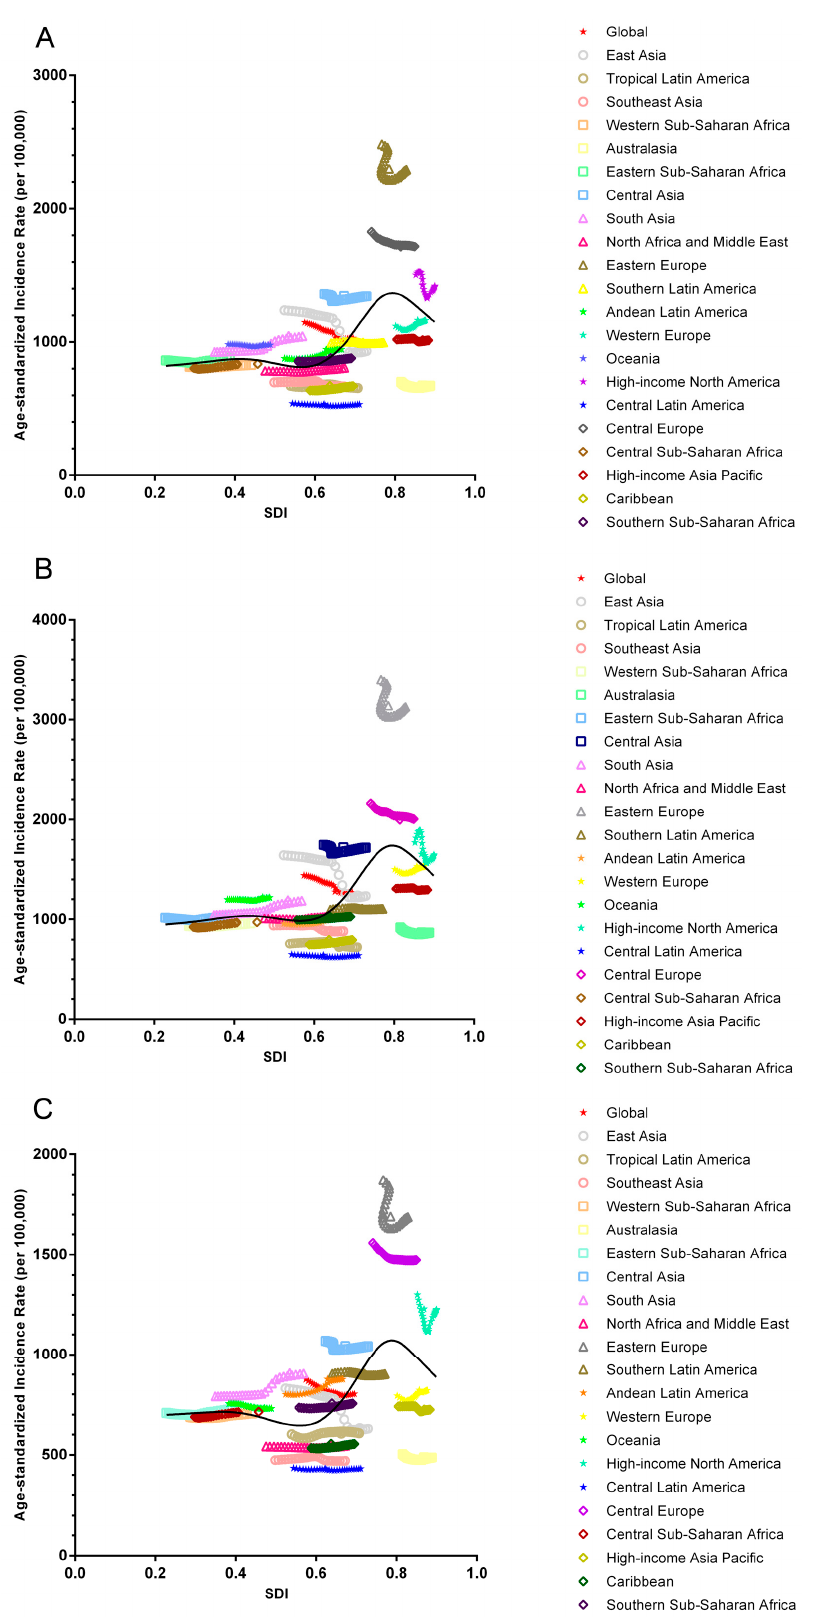
Figure 3. Annual percentage change of disability adjusted life years of urolithiasis stratified by gender and 21 regions. ( A ) APC of DALYs stratified by SDI levels of both gender; ( B ) APC of DALYs stratified by SDI levels of male. ( C ) APC of DALYs stratified by SDI levels of